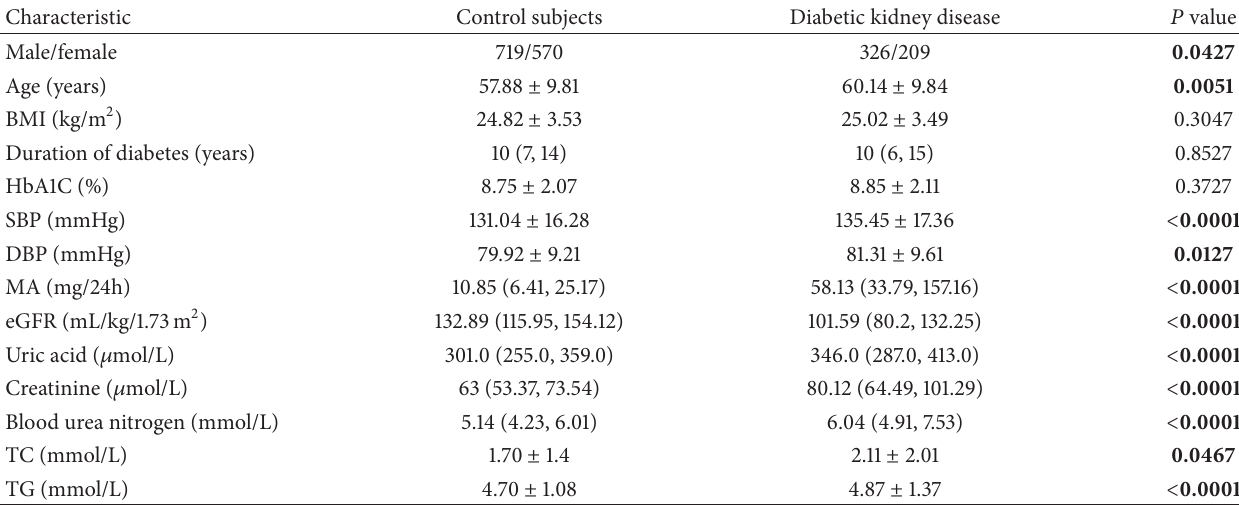
Table 1: The clinical characteristics of DKD group and control group.